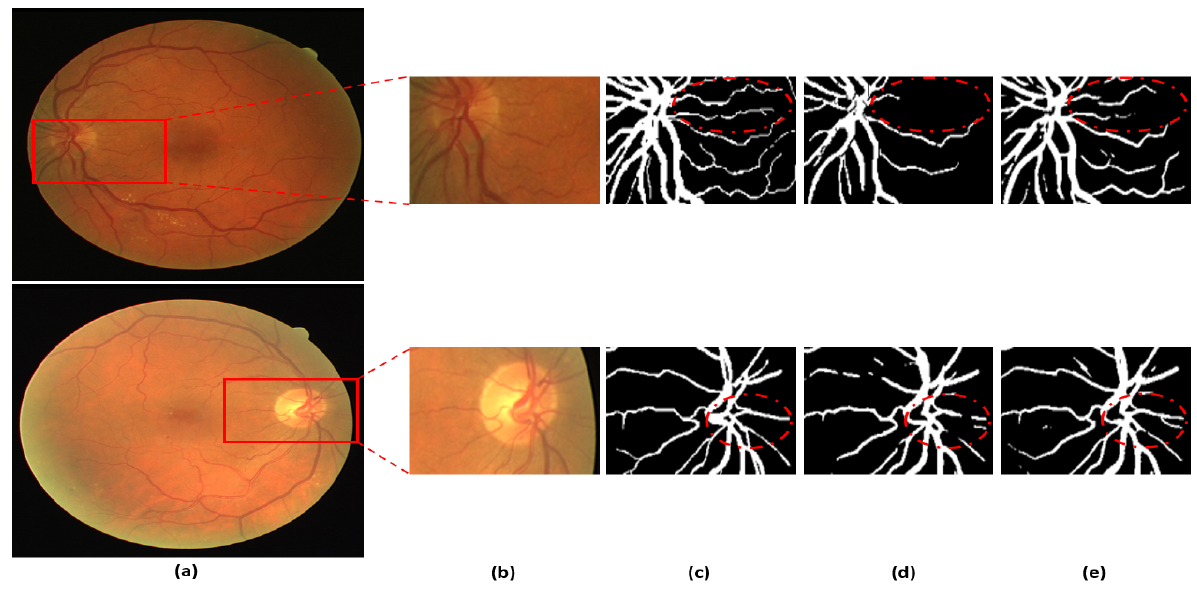
Figure 8. Visual comparison between DSA-Net, Vess-Net [20] (upper right), and U-Net [29] (lower right): ( a ) Original input image, ( b ) Enlarged input image, ( c ) Enlarged expert annotation, ( d ) Predicted mask image by Vess-Net [20] (upper), U-Net [29] (lower), and ( e ) Predicted image mask by DSA-Net.